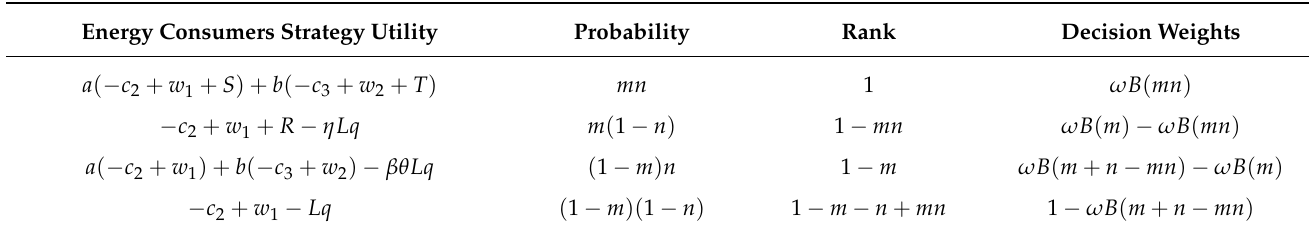
Table 2. Expected utility of energy consumers’ rank dependence considering